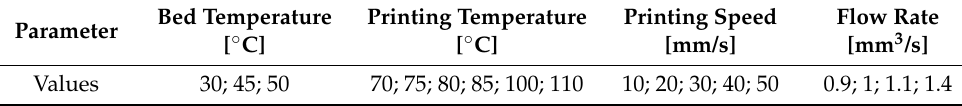
Figure 1. Representative images with the samples used for the parameters’ calibration: C-lines ( a ); calibration cube measurement ( b ); calibration cubes for different parameter settings ( c ). Table 1. Tested parameter settings for 3D printing PCL